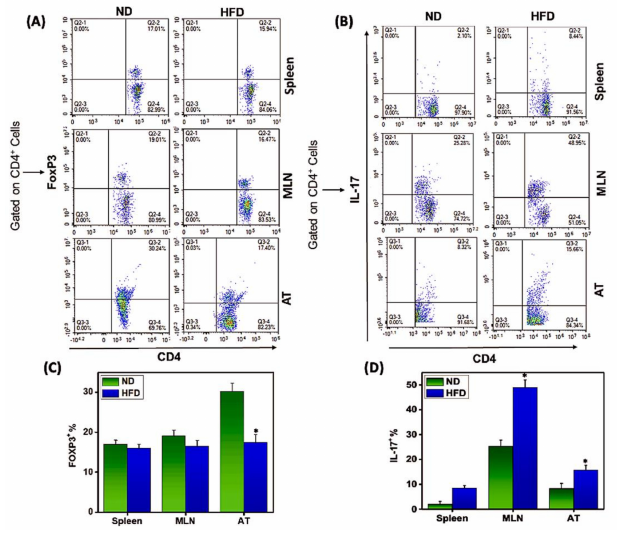
Figure 3. HFD-induced obesity differentially mediates the expression of Th17/Tregs in AT. Cells from spleens, MLNs, and AT were isolated from mice fed ND or HFD as described in the legend in Figure 2 and analyzed by flow cytometry gated on CD4 + T cells and antibodies specific for CD4, Foxp3, and Th17. ( A , B ) Changes in AT in the frequency of ( A ) CD4 + FoxP3 + Tregs or ( B ) CD4 + Th17 + Th17 cells from mice fed HFD or ND. ( C , D ) Percentage change in ( C ) Foxp3 + and ( D ) Th17 + in AT from mice fed HFD or ND. Relative values are expressed as the mean percentage of cells/mice ± SEM. Data shown are from a representative experiment; three independent experiments involving six mice/groups yielded similar results. Asterisks (*) indicate statistically significant differences ( p < 0.01) between ND and HFD